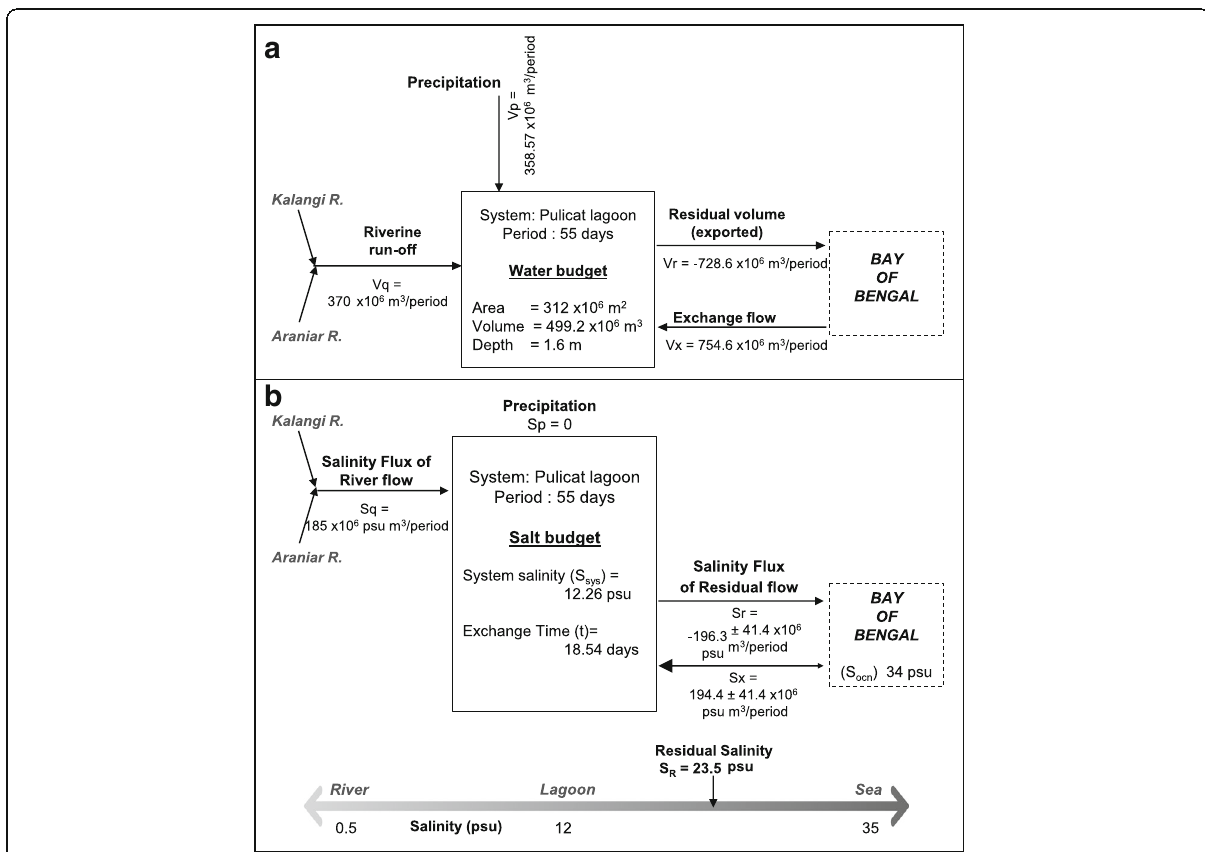
Fig. 6 LOICZ budgets for Pulicat lagoon during a period of 55 days corresponding to the northeast monsoonal rainfall of 2015. a shows the water fluxes and b shows the salinity